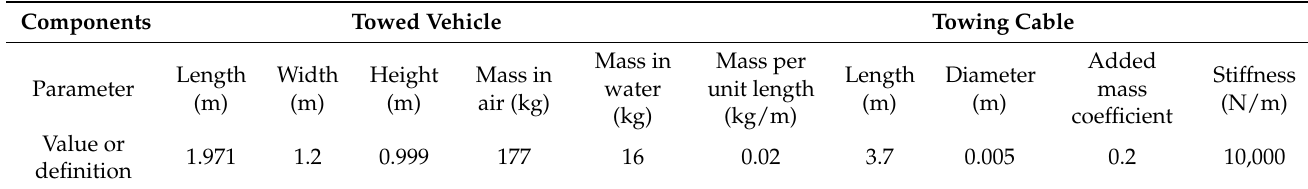
Figure 7. The towed vehicle for validation: ( a ) the simplified towed vehicle; ( b ) a photo of the towing test. Table 2. Primary parameters of the underwater towed system for